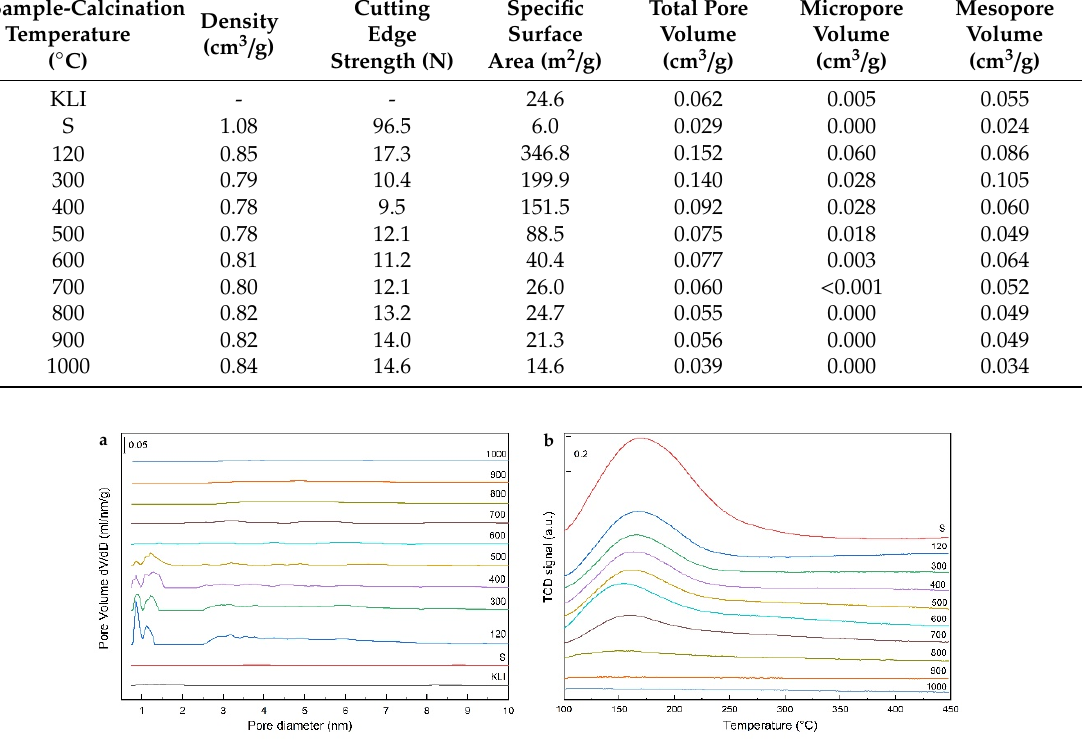
Figure 9. Pore size distribution ( a ) and NH 3 -TPD ( b ) of calcined zeolite